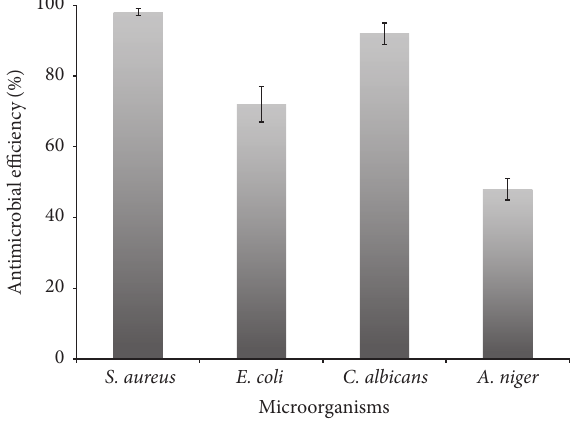
Figure 5: Antimicrobial activity of ZnO-3 against S. aureus , E. coli , C. albicans , and spores of A. niger .